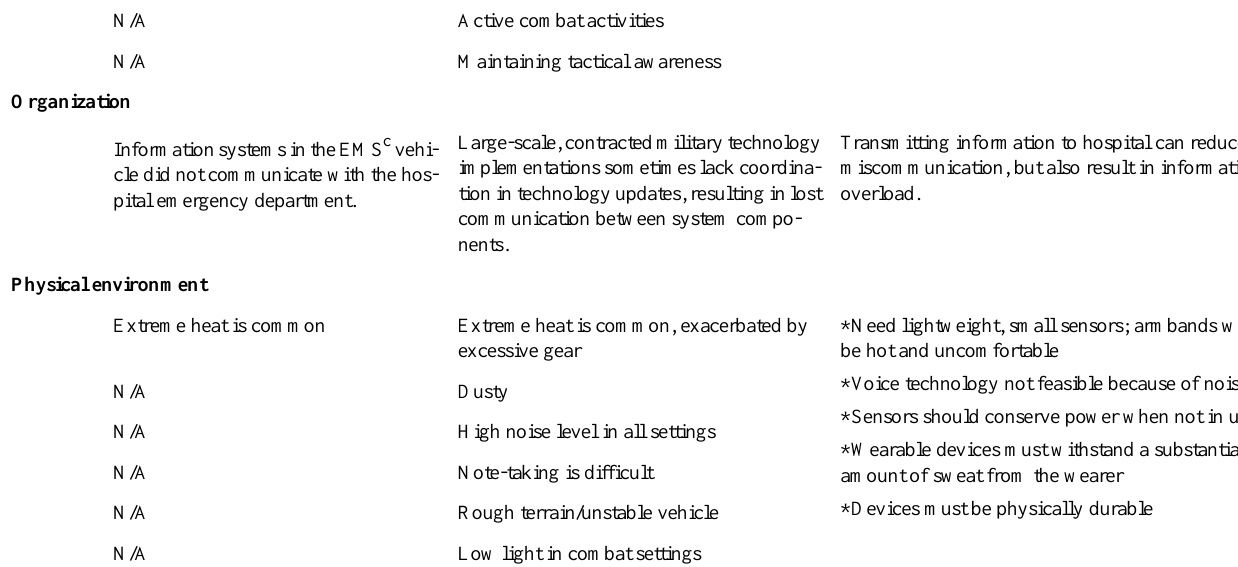
Table 1. Work system analysis for documentation in the field. Technology and